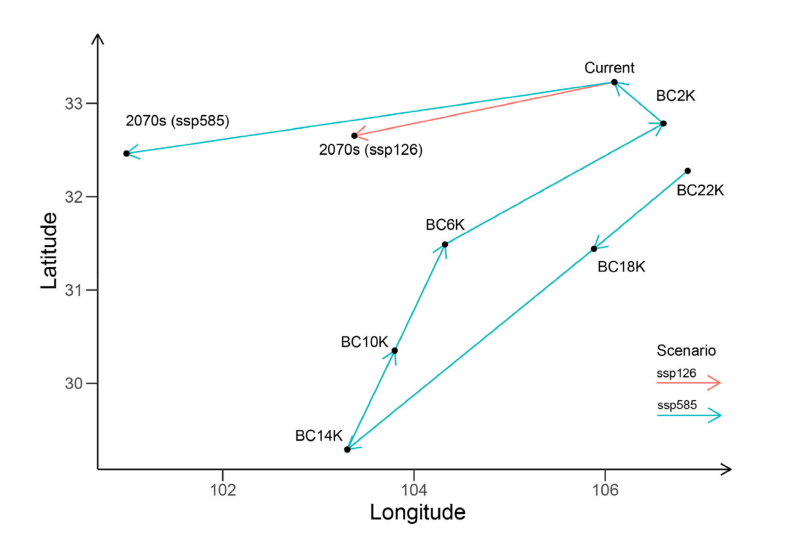
Figure 6. Distribution centroids of H. thibetanus from the Last Glacial Maximum to the 2070s.